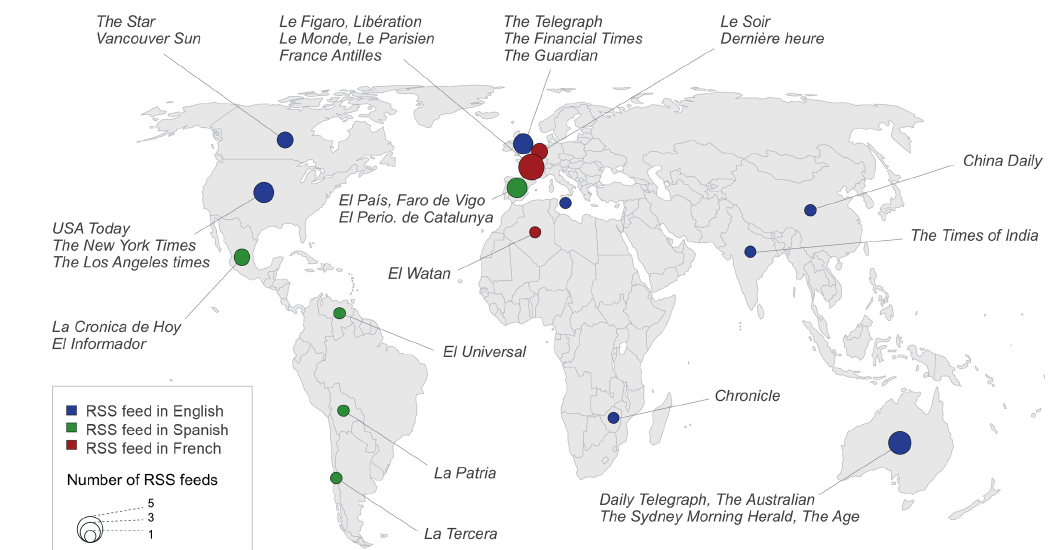
Figure 1. Corpus of news RSS feeds used, by origin and